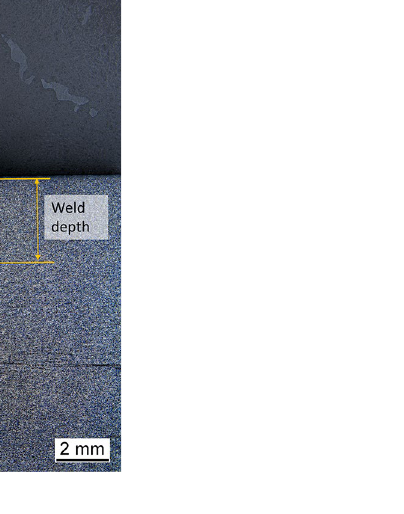
Figure 5. Hardness measurements